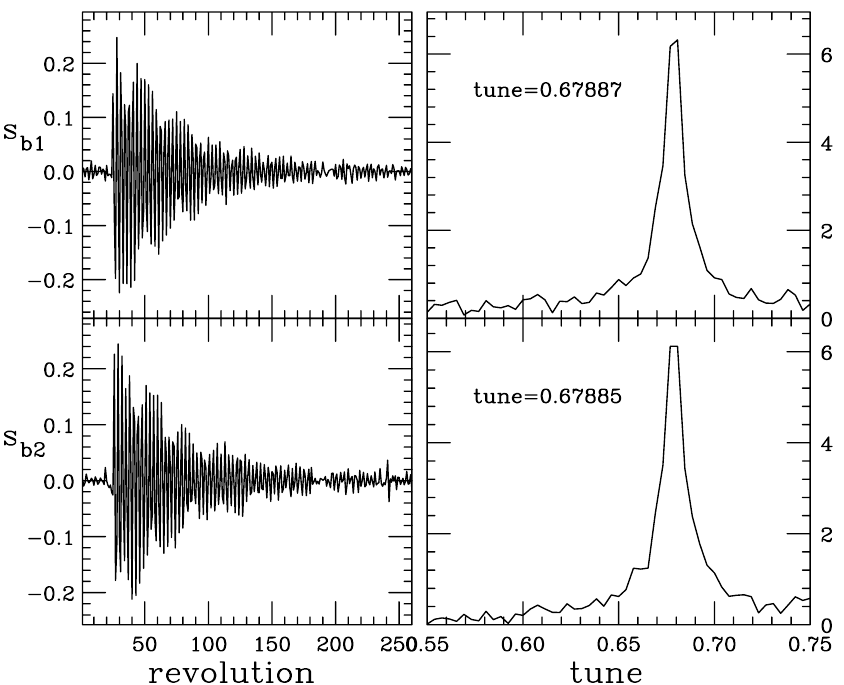
FIG. 7. Two modes of horizontal signal are shown on the left plots, and the corresponding FFT spectra are shown as the horizontal betatron tune. The ICA extracts a single betatron mode from data of all BPMs. The betatron mode is a purer sinusoidal signal and the tune evaluation method in Ref. [18] can be used to achieve higher precision. Note that the decoherence is not an independent signal, and thus cannot be